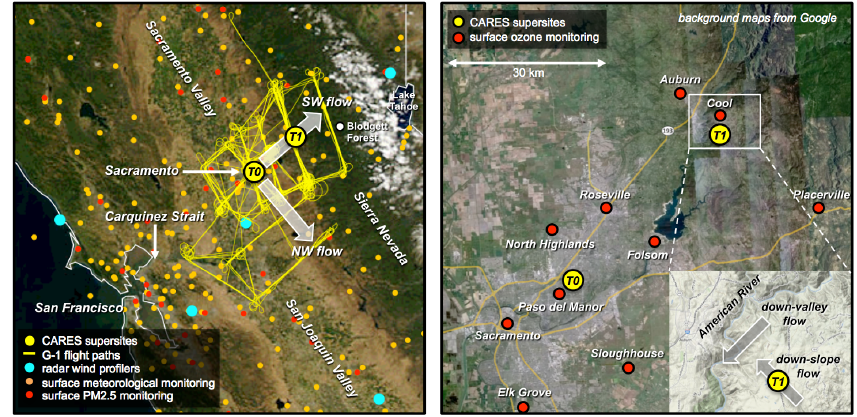
Figure 1. Locations of the primary surface sampling sites, T0 and T1, in relation to the G-1 flight paths (yellow lines) during CARES. Blue dots denote radar wind profilers, orange dots denote surface meteorological network, and red dots denote PM2.5 monitoring network.